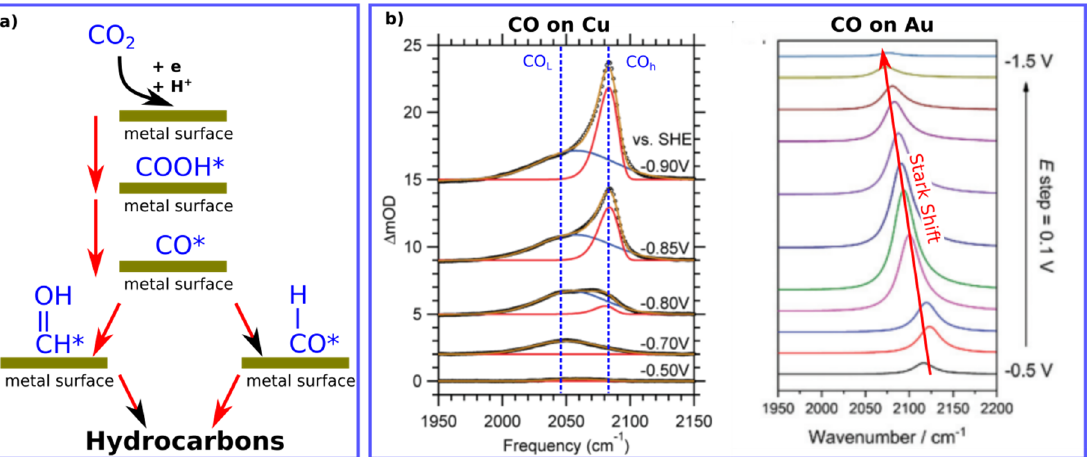
Figure 1. ( a ) Illustration for the important of CO intermediate during the reduction process of CO 2 into hydrocarbons. ( b ) Typical positions of adsorbed CO molecules on Cu (ATR-SEIRAS) and Au (VSFG) surfaces found by IR surface-sensitive techniques. Data are adapted with permissions from references